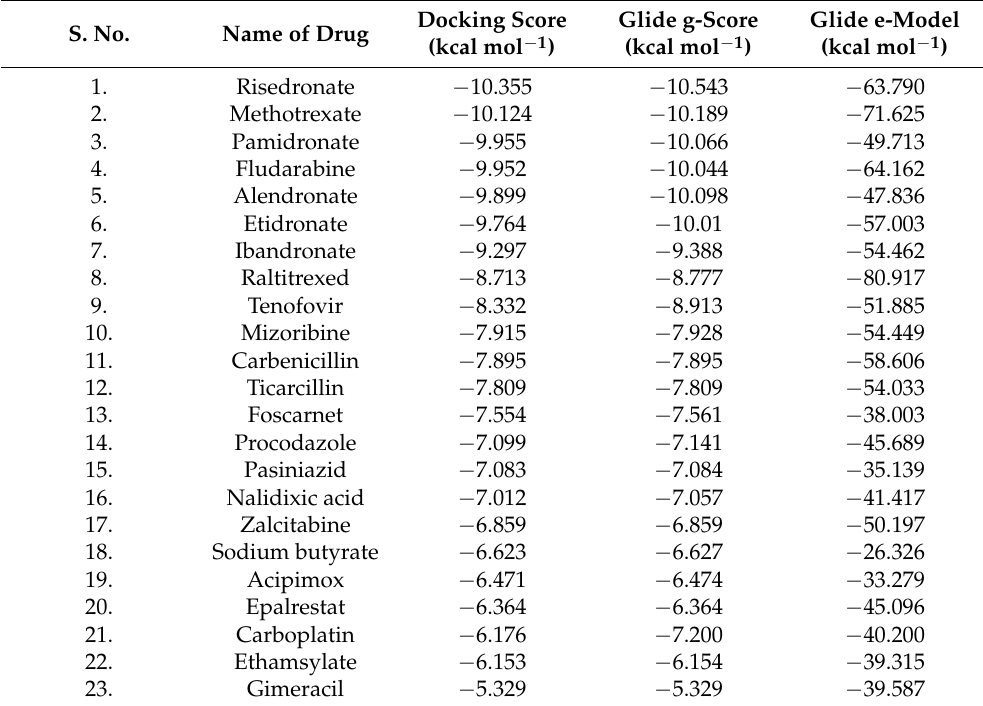
Table 1. Extra precision (XP) docking parameters of drugs shortlisted on the basis of SP score ( ≤− 8.0 kcal mol − 1